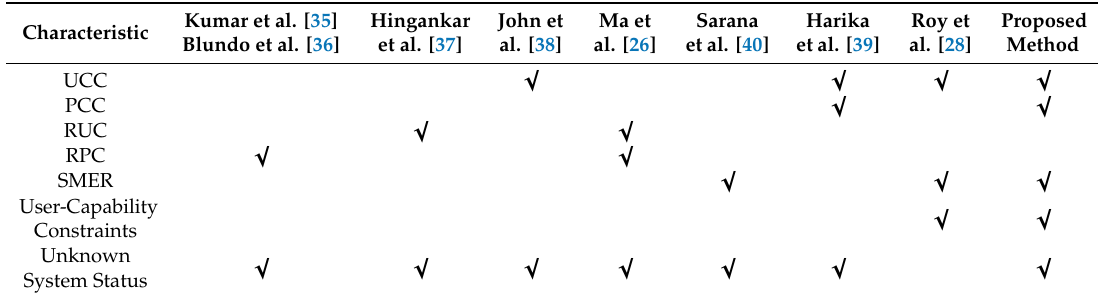
Table 23. Comparison of security